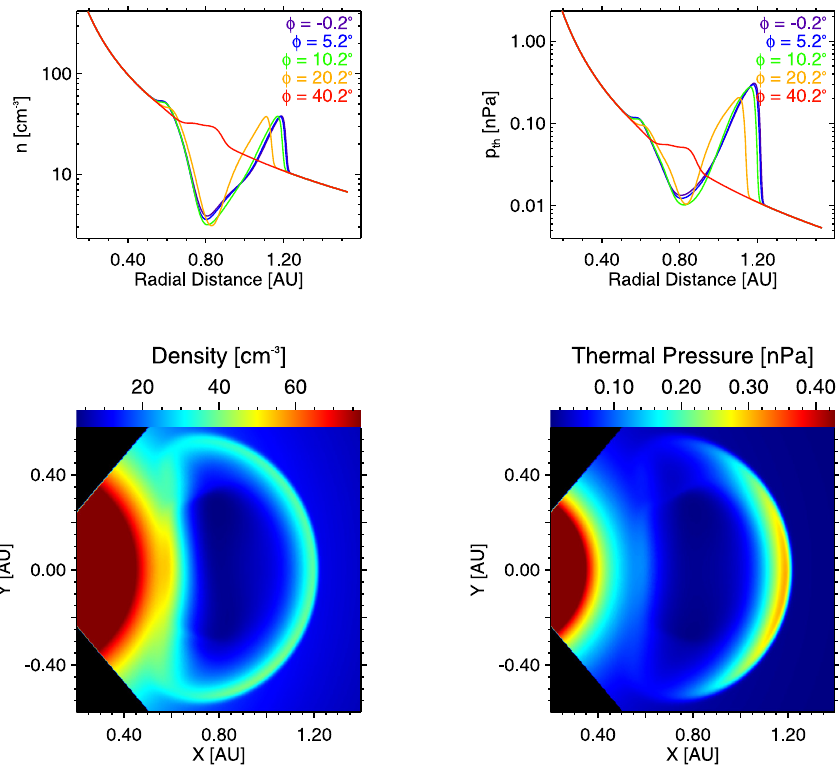
Fig. 5. Density (left) and thermal pressure (right) for the H + e magnetic cloud near Earth.